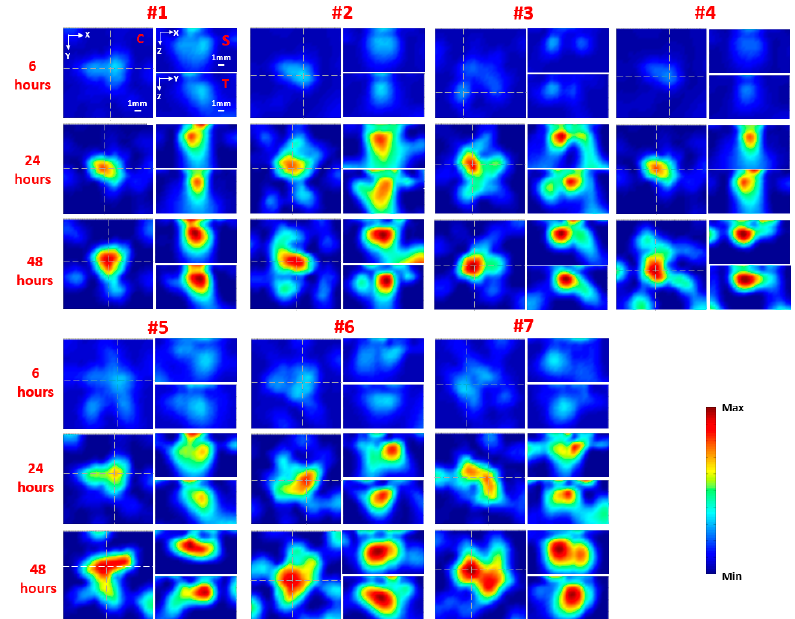
Figure 4. Reconstructed FMT images along representative coronal (C), sagittal (S), and transverse (T) planes for the seven mice in the targeted (NIR 830-ATF-IONP) group at 6, 24, and 48 h post injection of nanoprobes. The C slice is indicated in the first image for mouse #1 (upper left), while the S and T slices are also noted in the other two images in the first set of images for mouse #1, which are given along the white dashed lines that are crossing the center of the tumor in the coronal image.